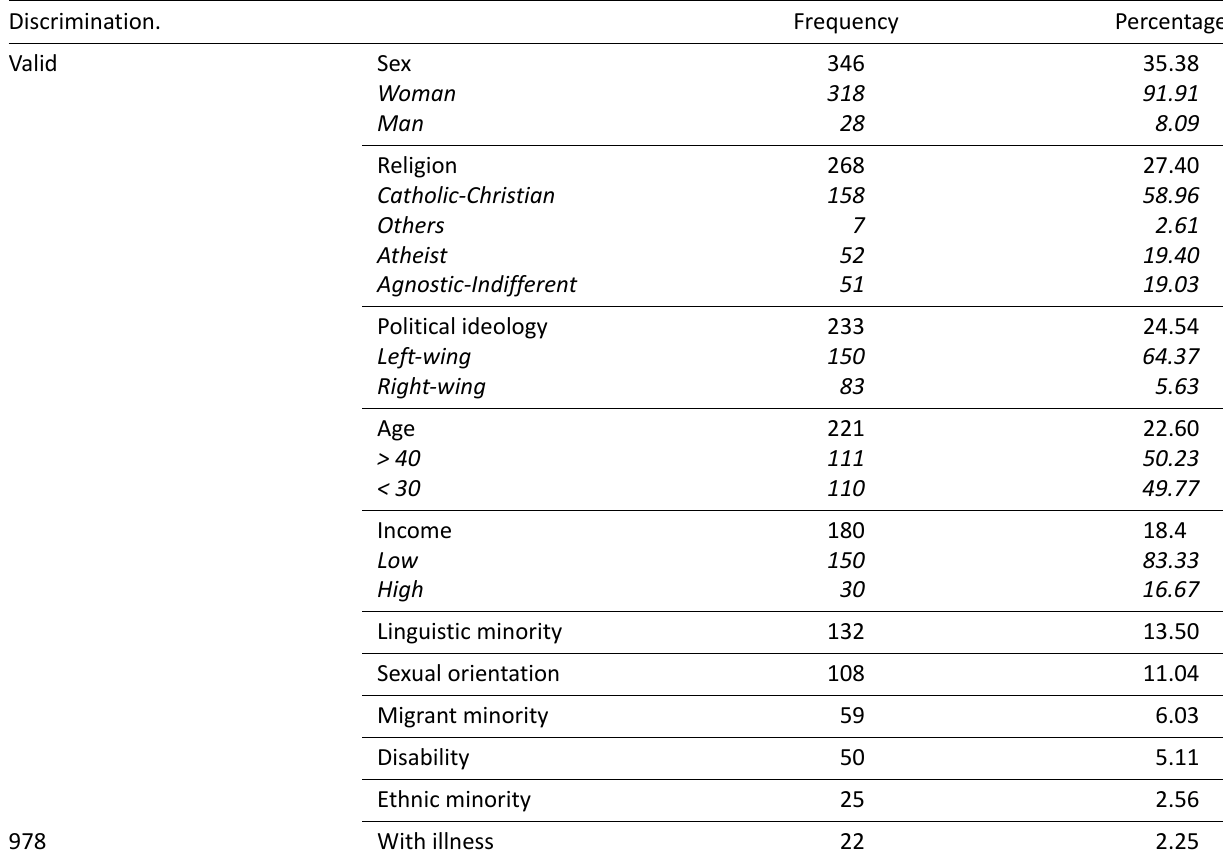
Table 3. Feeling of discrimination by collective. Discrimination.